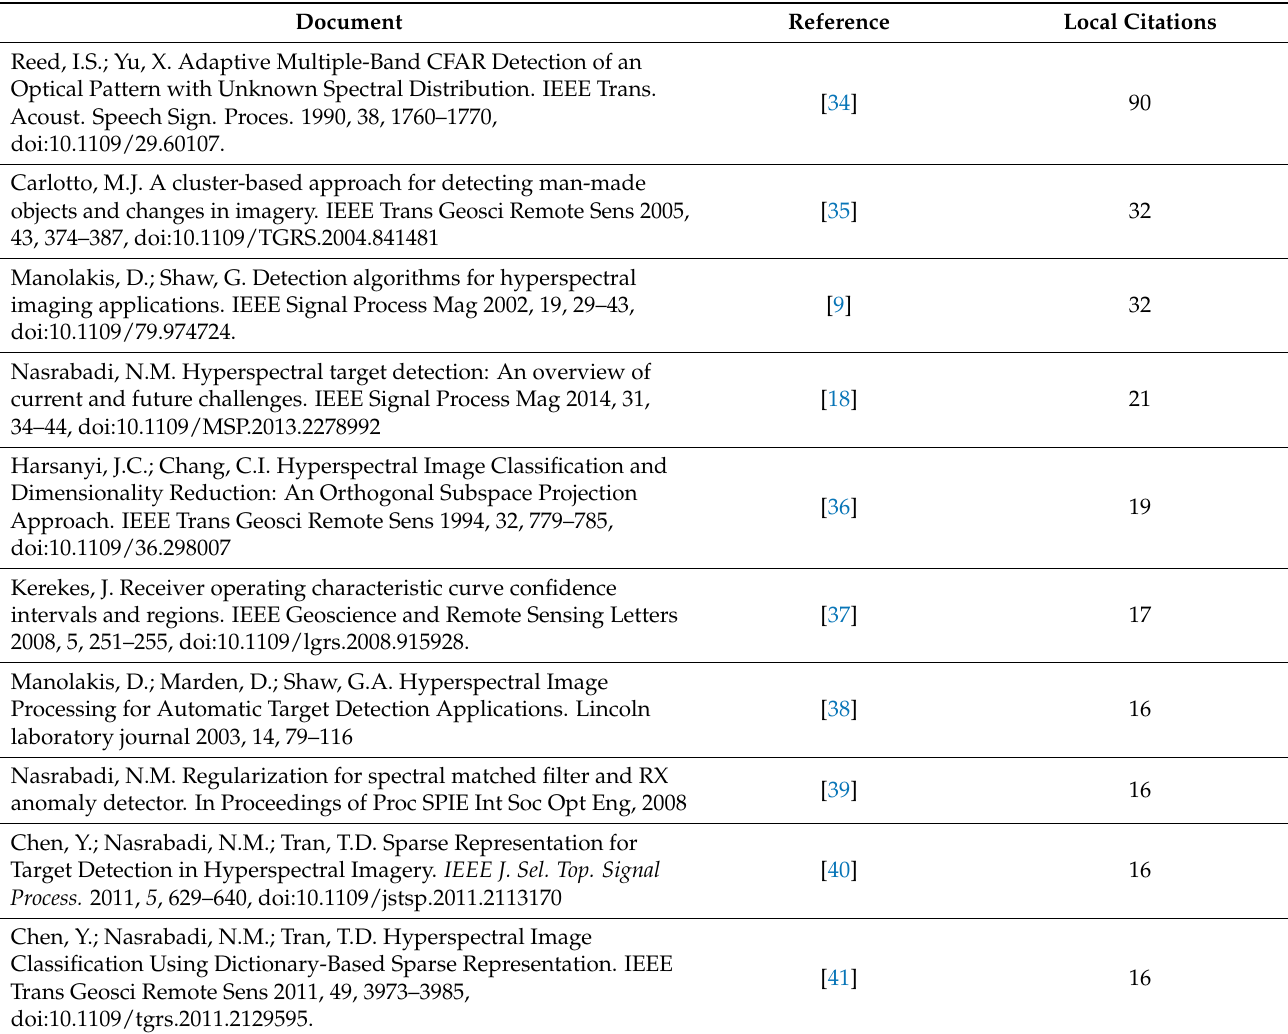
Table 5. The top 10 documents with the highest number of local citations that were not selected within the applied search strategy (Figure